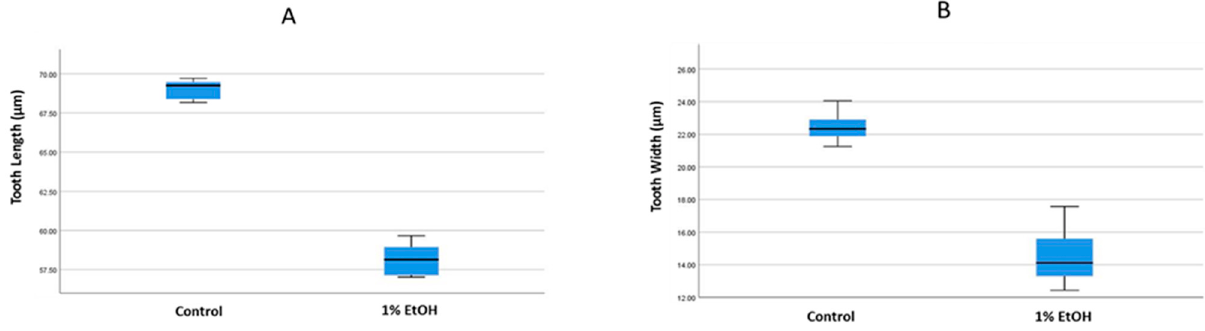
arrowhead) lb: lower base; tp: tip of the tooth; ub: upper base. Figure 2. Comparing the tooth ( A ) length and ( B ) width in control and 1% alcohol-treated samples at 15 days post-fertilisation. In ( A ), the mean length is 69.71 µm for the control group and 58.23 µm for 1% alcohol-treated group. There was a significant difference ( p < 0.05) between the groups. In ( B ), the mean width was 22.73 µm for control group and 14.22 µm for the 1% alcohol-treated group. There was a significant difference between the groups.